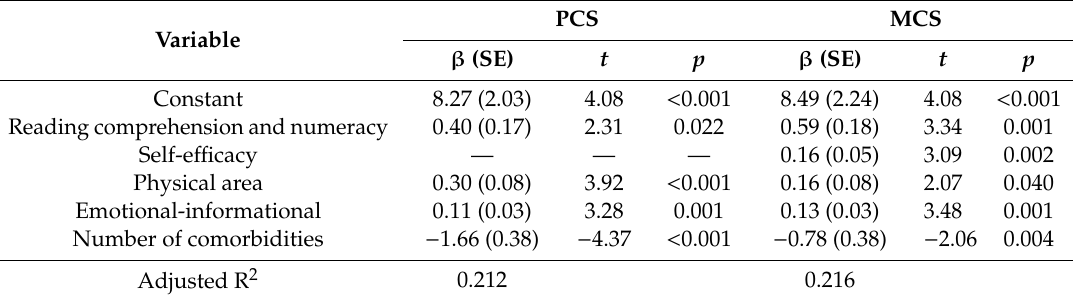
Table 4. Results of the stepwise multiple regression analysis for HRQOL ( N =